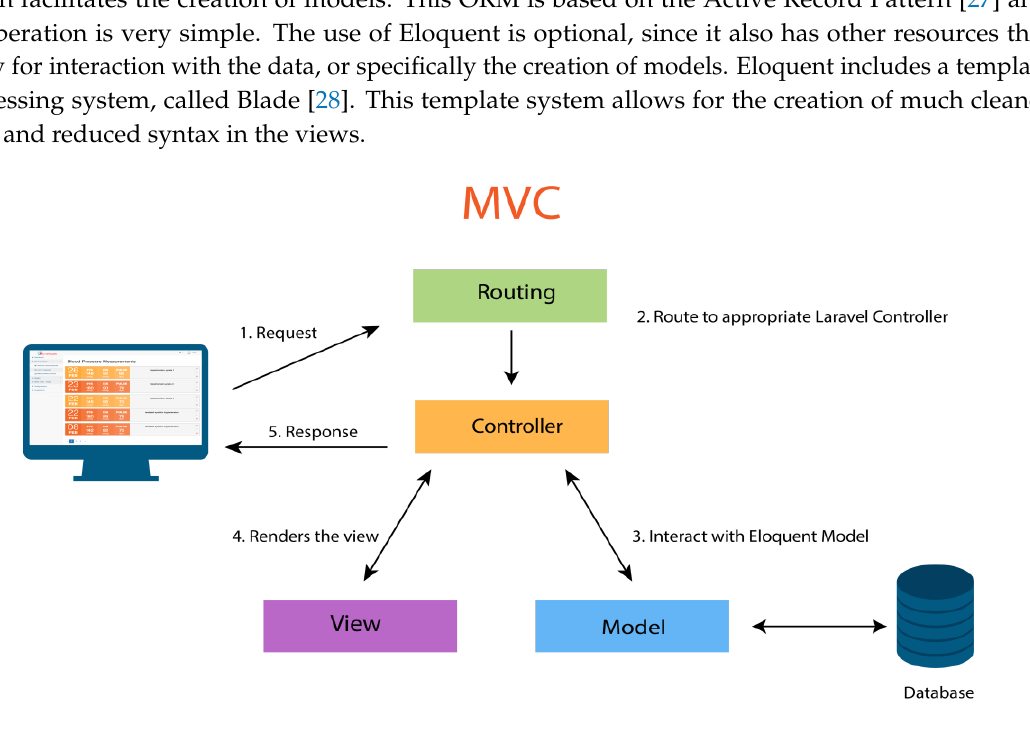
Figure 4. Model-View-Controller (MVC) software architecture pattern.